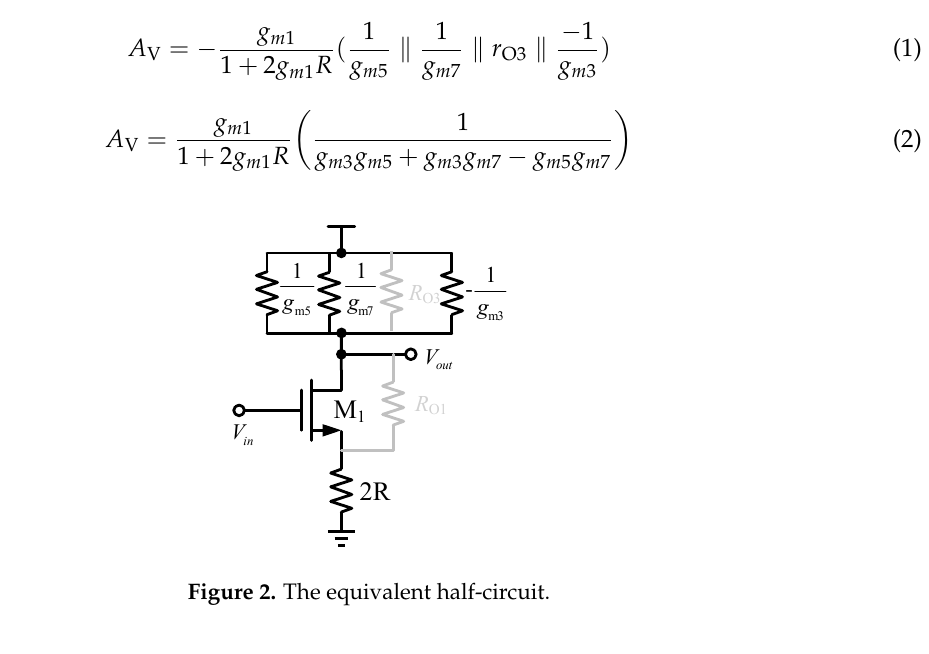
Figure 3. Equivalent half-circuit with noise sources.